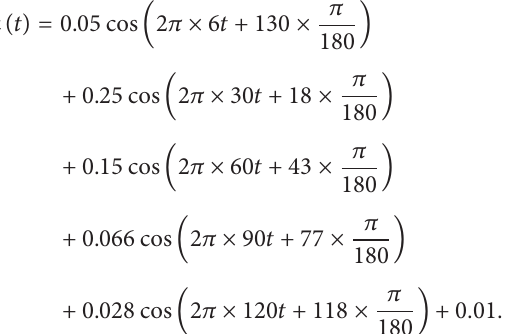
the trend item of velocity and displacement signal obtained by TDI is eliminated through least squares fitting. The comparison between the integral results and the theoretical signals is depicted in Figure 3. Figure 3 indicates that the low-frequency trend item of TDI in the first time is commendably eliminated through zero-mean processing and least squares fitting. However, because the effect of noise cannot be removed, the integral results still have considerable errors. With the increase in integral times, the errors gradually increase. The results of TDI in the second time produce obvious